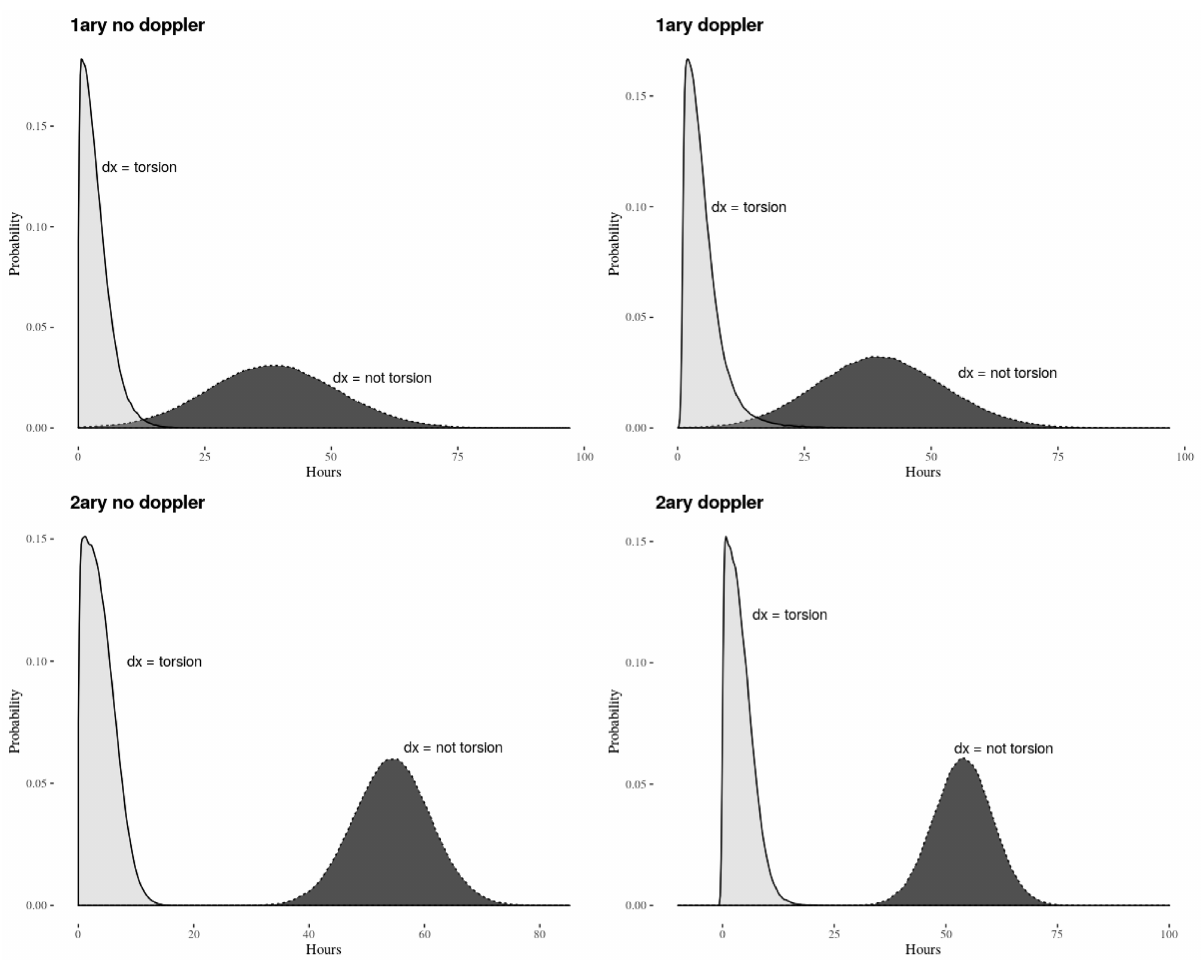
Figure 3 - Distribution of transfer times according to facilities´ level of care (1ary=primary, 2ary=secondary), first diagnosis (dx=torsion, dx=not torsion) and Doppler-US request computed from the Bayesian linear regression model. Horizontal axis, transfer time in hours; vertical axis,